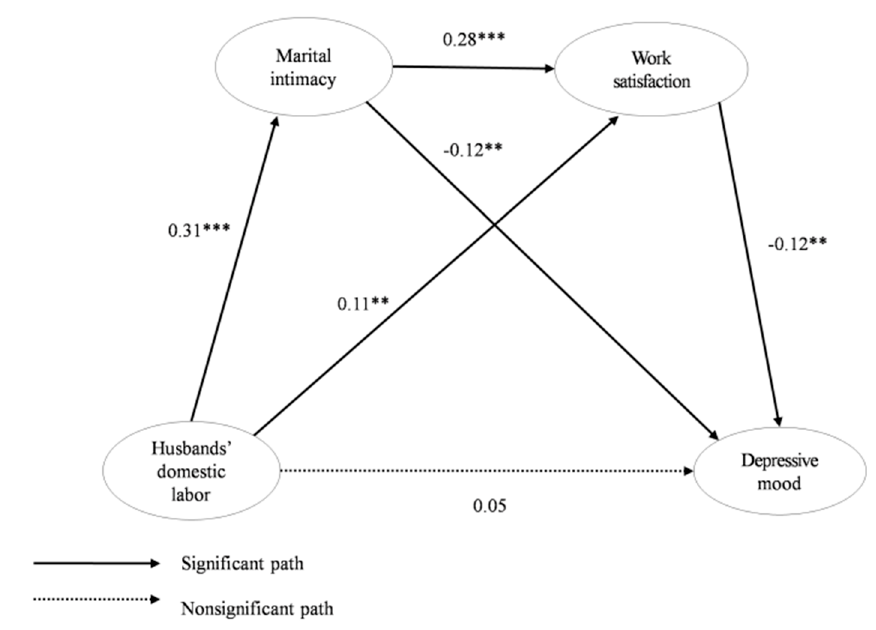
Figure 1. Final model. ** p < 0.01, *** p < 0.001.